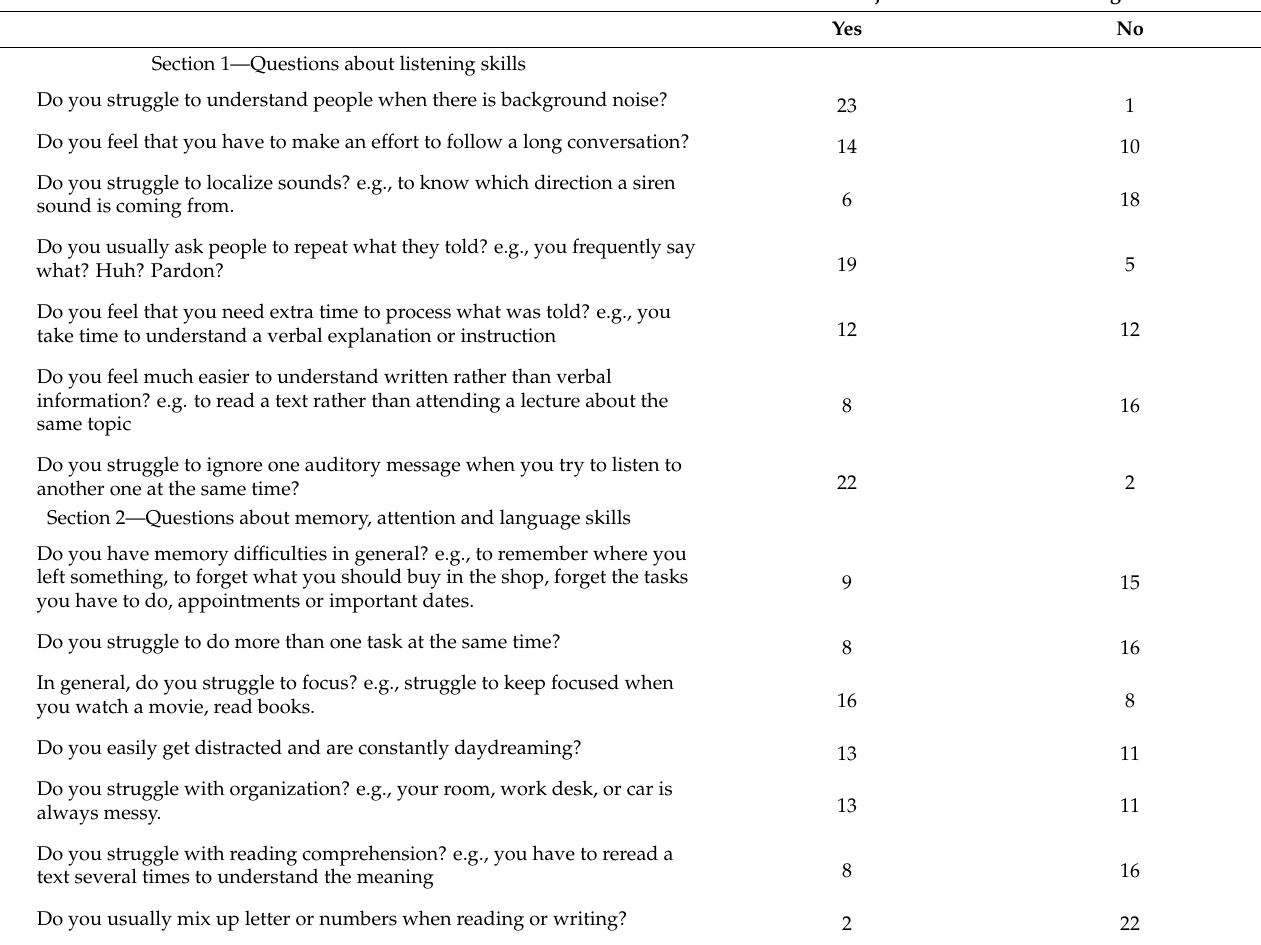
Table 1. Questionnaire about listening, memory, attention and language